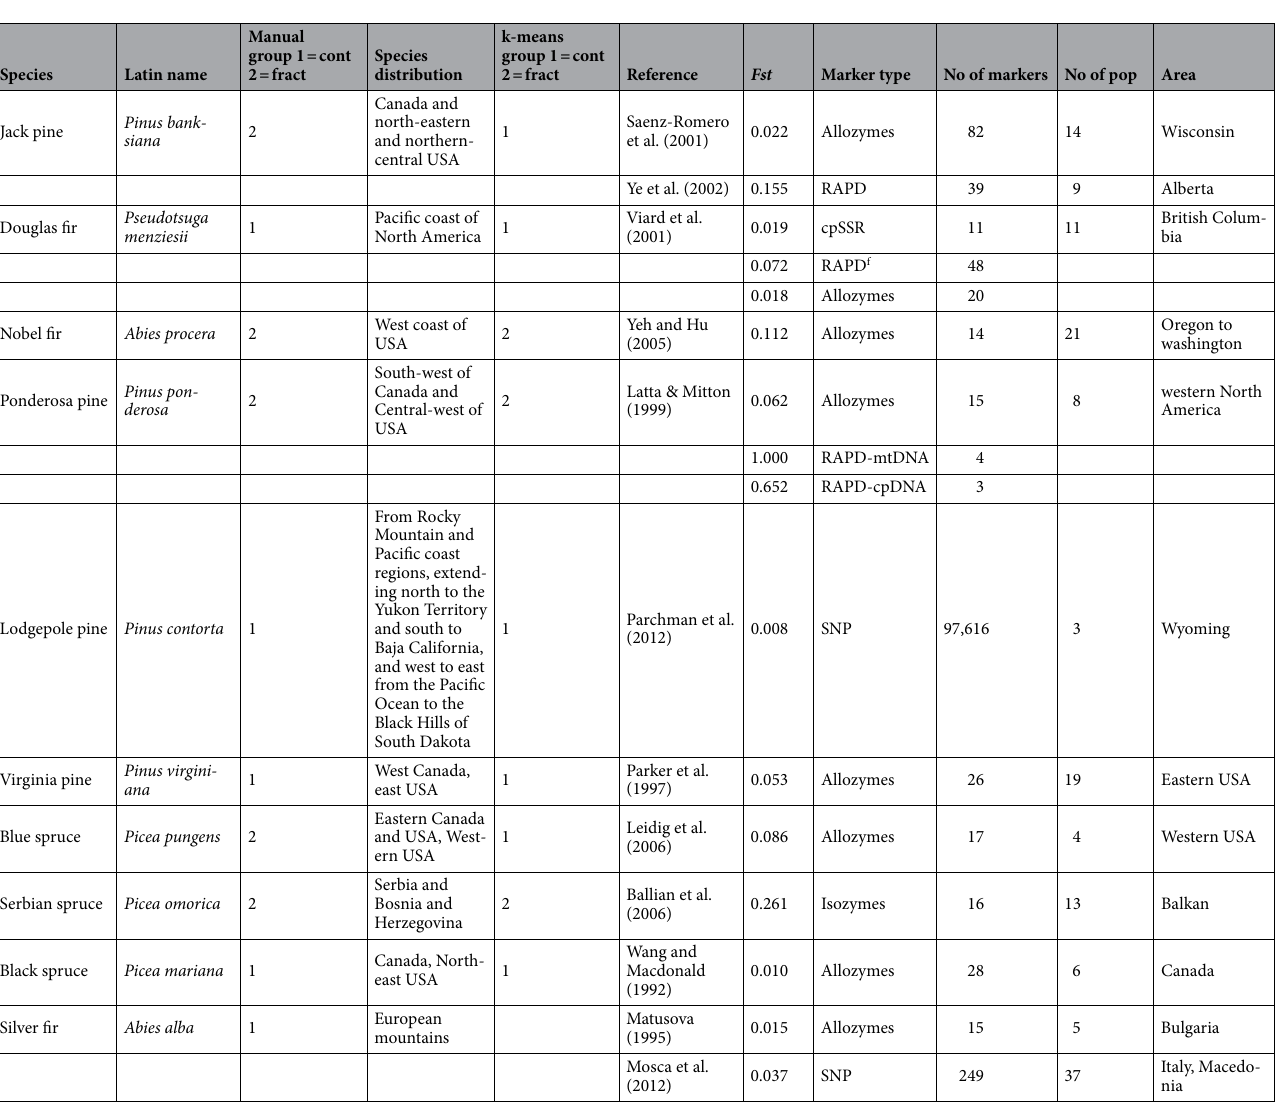
Table 1. Species connectivity using the United States Department of Agriculture Natural Resources Conservation Service (http:// plants. usda. gov/) for the American species and Agro Forestry Tree Database (http:// www. world agrof orest ry. org/) for European species. References provided in Supplementary information. a Expressed sequence tags—simple-sequence repeats. b Amplified fragment length polymorphism. c Single nucleotide polymorphism. d Nuclear simple-sequence repeats. e Chloroplast simple-sequence repeats. f